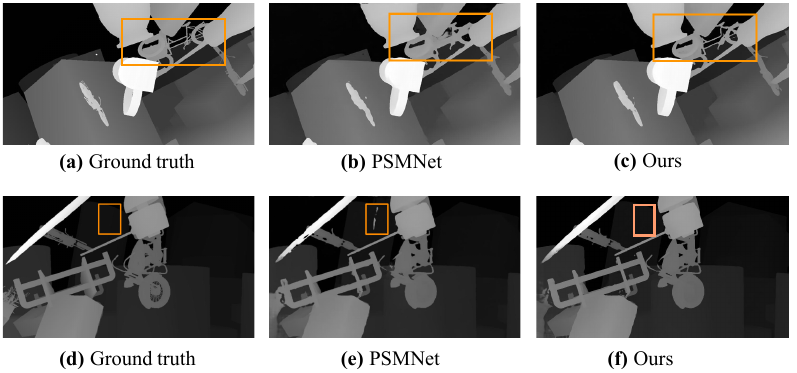
Figure 1. Illustration of disparity maps. ( a , d ) are the ground-truth disparity maps. ( b , e ) are disparity maps obtained by PSMNet [2]. ( b ) shows blurred disparity values on sharp boundaries and ( e ) shows the discontinuous disparities of smooth regions. ( c , f ) are the results of our model. Orange boxes on the images show the differences between the disparity